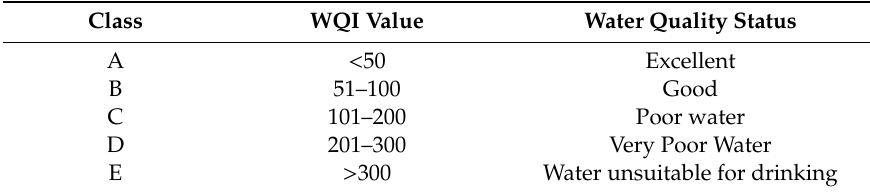
Table 3. Characterization of water quality based on water quality index (WQI) value